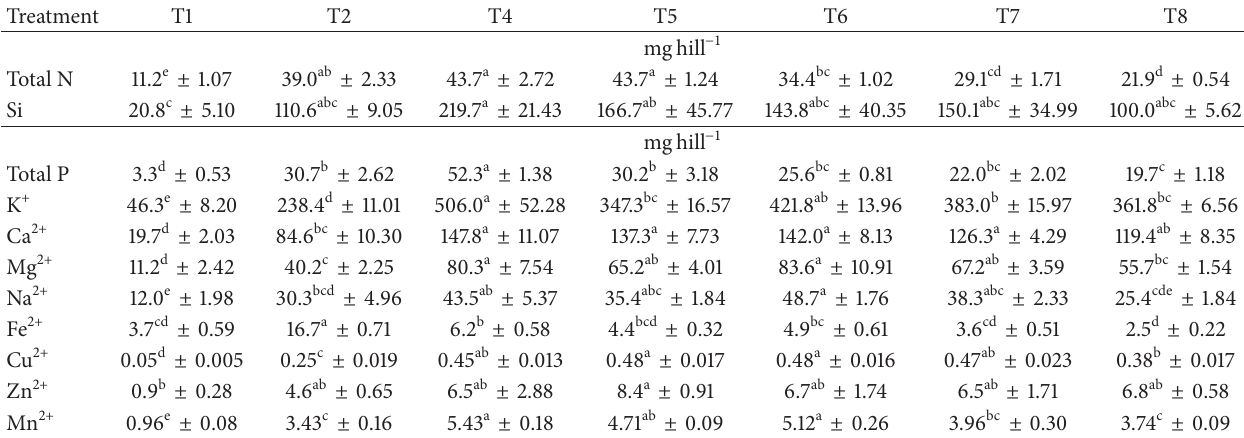
Table 9: Effects of coapplication of biochar and urea on nutrients uptake in a pot study.